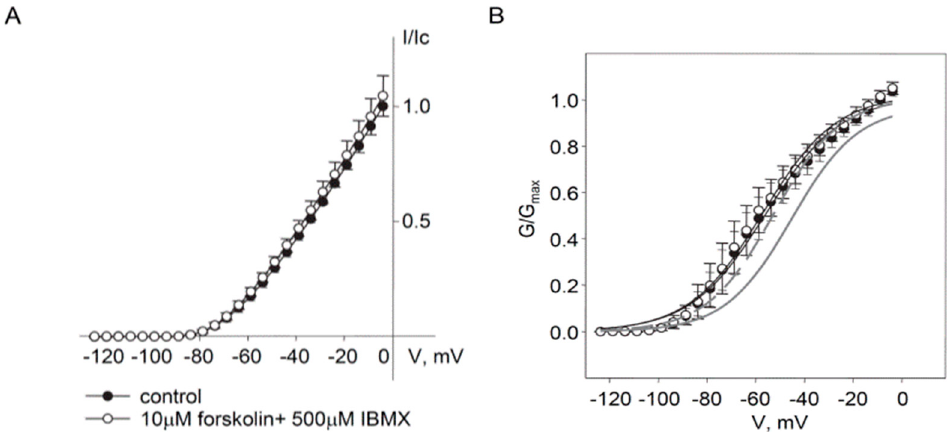
Figure 4. Phosphomimetic mutant Kv7.5S53D has negatively shifted voltage-dependence of activation and is insensitive to forskolin/IBMX. ( A ) I–V relationships of Kv7.5 S53D current recorded before (filled circles, n = 4) and after (open circles, n = 4) application of forskolin (10 µ M) in combination with IBMX (500 µ M) for 5 min. ( B ) Mean fractional conductance plots calculated from tail currents measured in control (filled circles) and in the presence of forskolin/IBMX (open circles), fitted to a Boltzmann distribution (V 0.5 = − 56.8 ± 5.3 mV in the absence and − 58.4 ± 5.9 mV in the presence of forskolin/IBMX, n = 4); mean fractional conductance plots of wild-type Kv7.5 channels are shown in a gray solid line for control and gray dashed line in the presence of forskolin/IBMX.